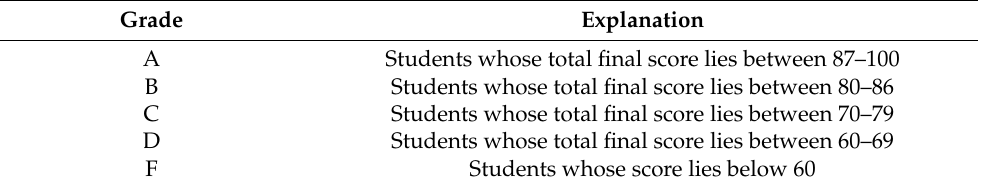
Table 3. Explanation of students’ grade at the end of the course.